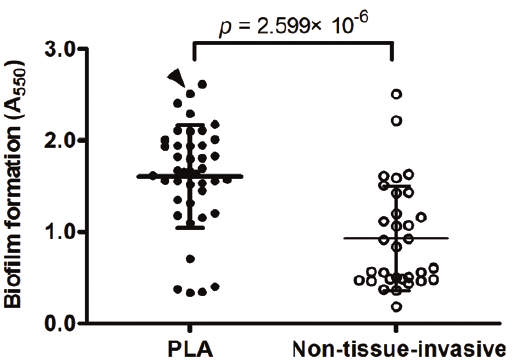
Figure 1. Biofilm formation of K.pneumoniae clinical isolates. Overnight cultures of K. pneumoniae PLA and non-tissue-invasive strains were grown in fresh Luria-Bertani broth at a ratio of 1:100 in polystyrene plates at 37 u C for 5 hr. The sessile bacteria were stained with crystal violet, washed to remove unbound cells, eluted with 95% ethanol, and monitored the absorbance at 550 nm. Data shown are the means of 3 independent experiments (duplicate in each experiment), and error bars shows the standard deviation (SDs). p =2.599 6 10 2 6 , by Student’s